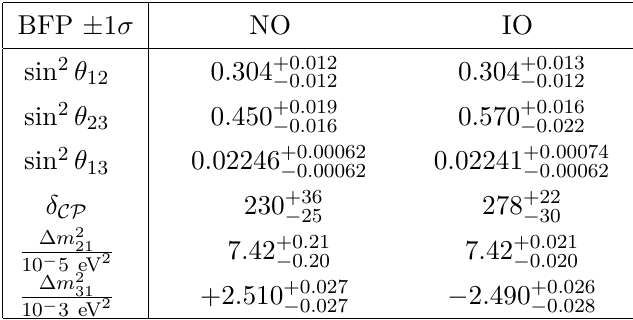
Table 1 . Best fit parameters (BFP) for the neutrino mixing angles, CP phase, and mass differences — for both the Normal Ordering (NO) and Inverted Ordering (IO) scenarios. These are the global fit values determined by Nufit [95], which include the Super-Kamiokande atmospheric neutrino data, and which we use for our